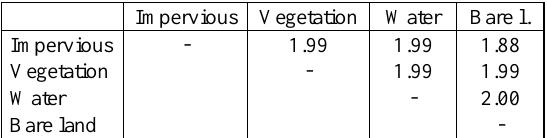
Table 2. Separability index values for different pairs of land